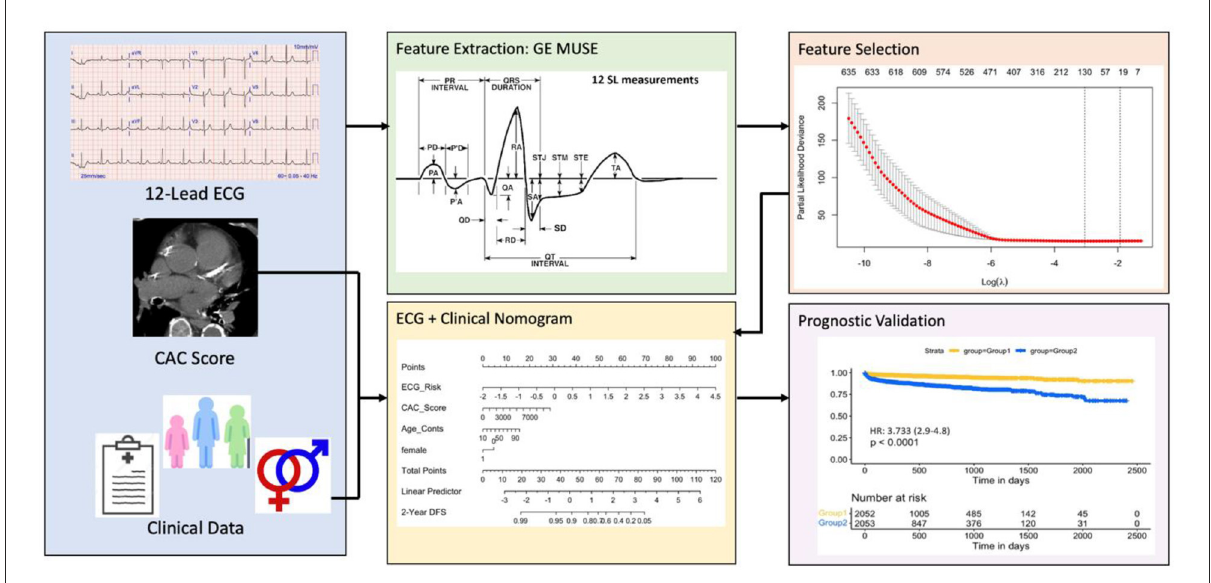
FIGURE1 Overall workflow. The first step involves collecting ECG tests, manual CAC scores and clinical data from eligible patients. The ECG features are then automatically extracted using the commercially available GE MUSE software. Top ECG features were selected using the LASSO feature selection method and used for constructing eRiS. M nom was constructed using clinical features and eRiS. M ecg and M nom were validated for prognostic performance and predicting downstream MACE events. LASSO: least absolute shrinkage and selection operator; eRiS: ECG risk score, Mecg: Cox PH model using eRiS alone; Mnom: Nomogram with eRiS, CAC and clinical